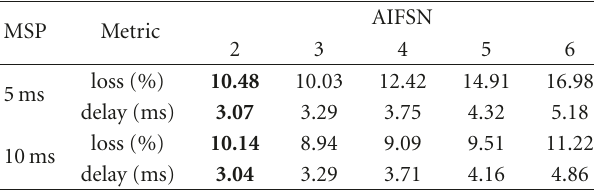
Table 2: E ff ects of varying AIFSN on the RT tra ffi c, for 20 RT stations—MSP = 5 ms and